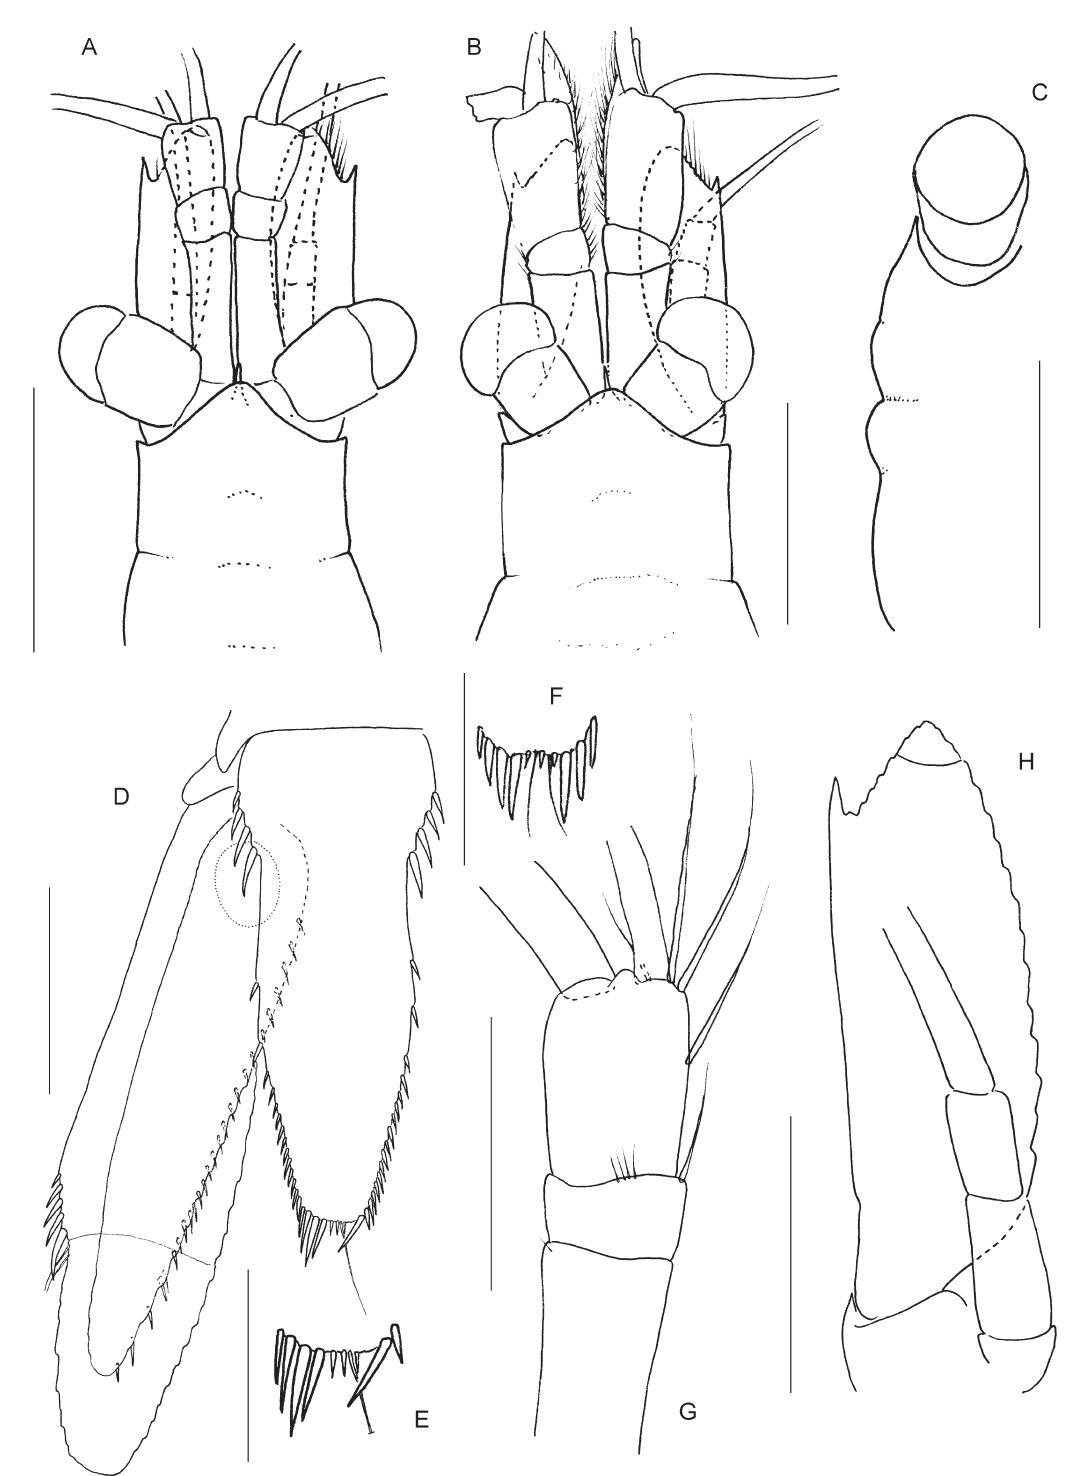
Fig. 3. Siriella bassi sp. nov., Australia, Victoria, Western Bass Strait. A . ♀, a nterior part of body. B . ♂, a nterior part of body. C . Anterior part of carapace, lateral view. D . Telson and left uropods. E . ♀, posterior part of telson . F . ♂, posterior part of telson. G . Peduncle of antenna 1, dorsal view. H . Antennal scale and peduncle of antenna 2, ventral view. A, C–E, G–H = holotype, ♀, length 8.5 mm; B, F = paratype, ♂, length 7.5 mm. Scale bars: A–C = 1 mm; D, G–H = 0.25 mm; E–F = 0.1